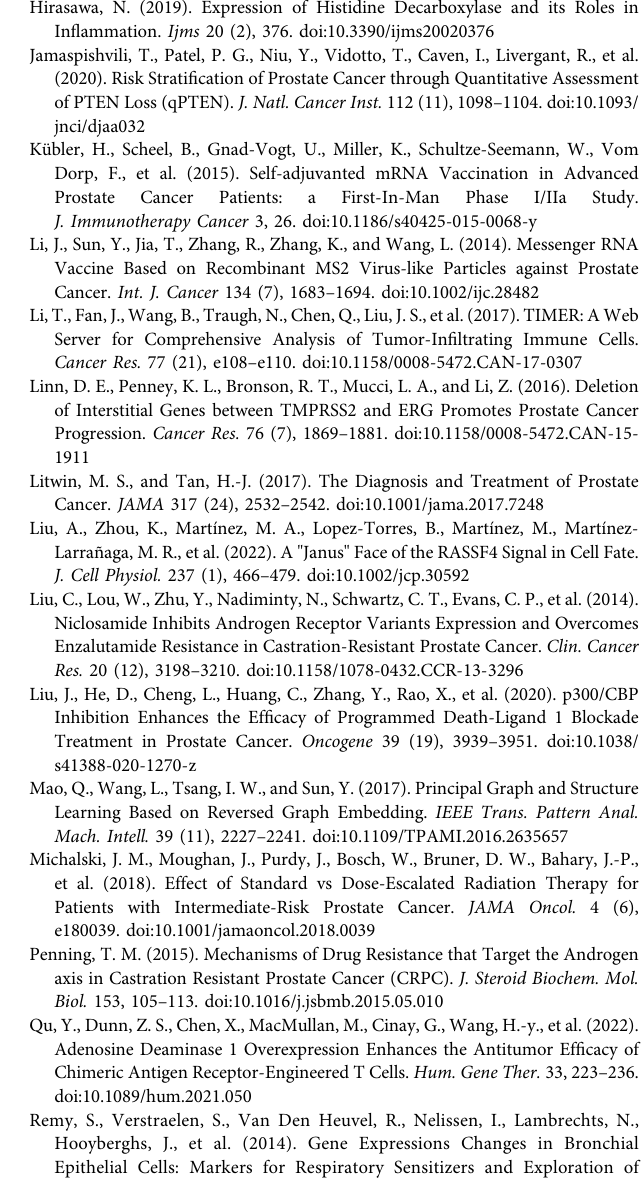
Supplementary Table S1 | The ampli fi ed genes of PRAD in TCGA database. Supplementary Table S2 | The overexpressed genes ofPRADin TCGA database. Supplementary Table S3 | The mutant genes of PRAD in TCGA